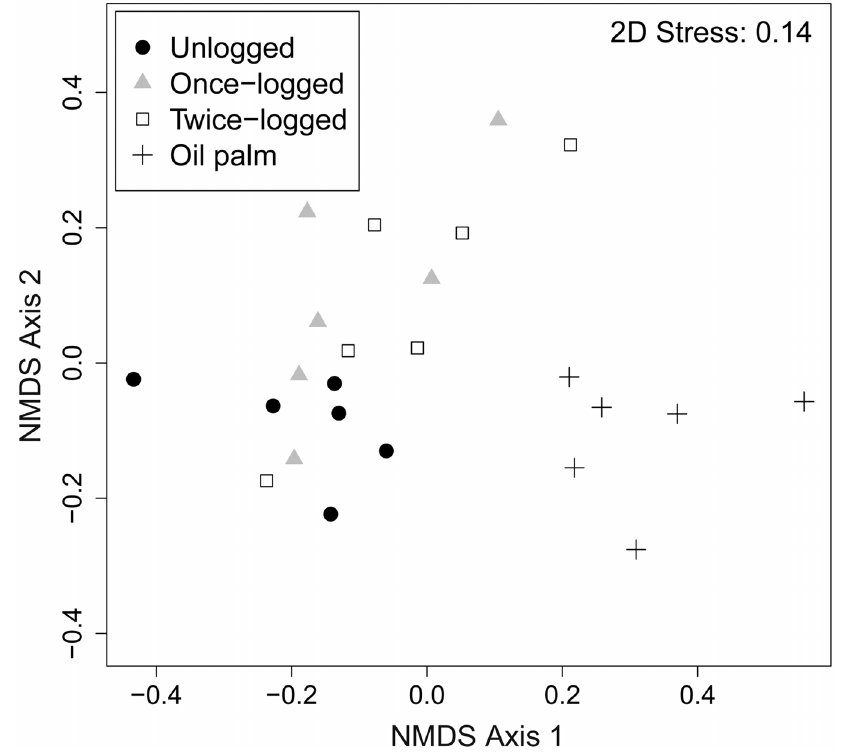
Figure 2. Non-metric multidimensional scaling (NMDS) ordination showing clustering of fungal communities among different land uses in Sabah, Malaysian Borneo.